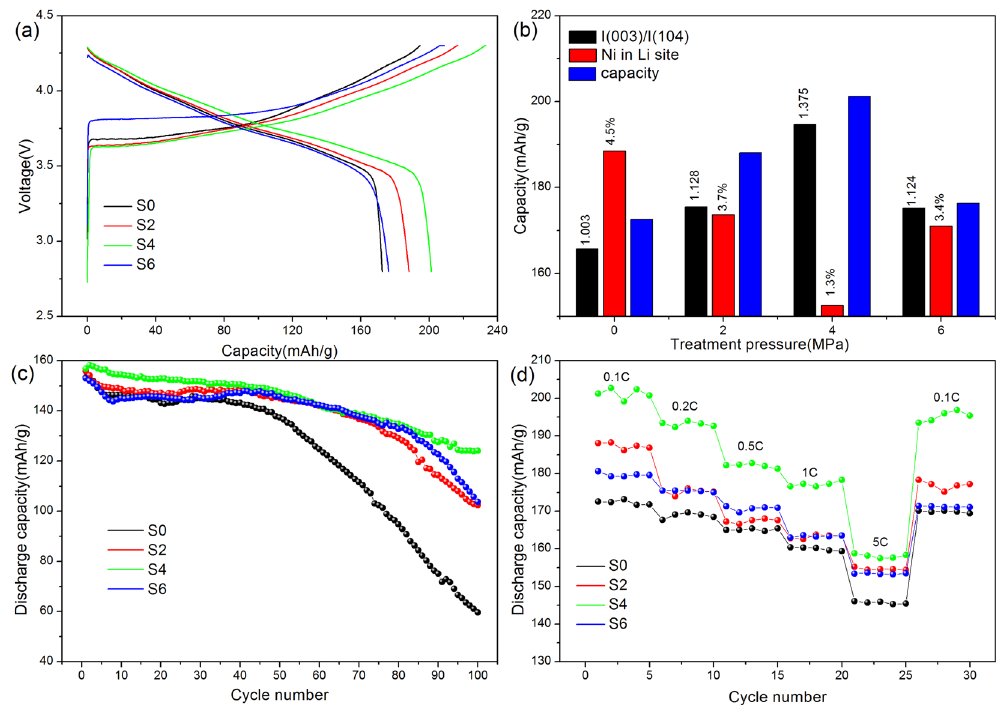
Figure 4. ( a ) Initial charge and discharge curves at 0.5C rate; ( b ) relationship among the I (003) /I (104) , cationic disordering and the discharge capacity; ( c ) cyclic performance at 5C rate; ( d ) rate performance of